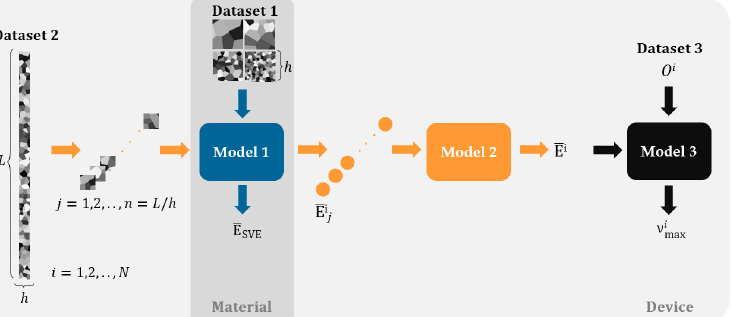
Figure 1. Overall model schematic, composed of three data-driven submodels to account for material- and geometry-related uncertainties at different (termed material and device) length scales.